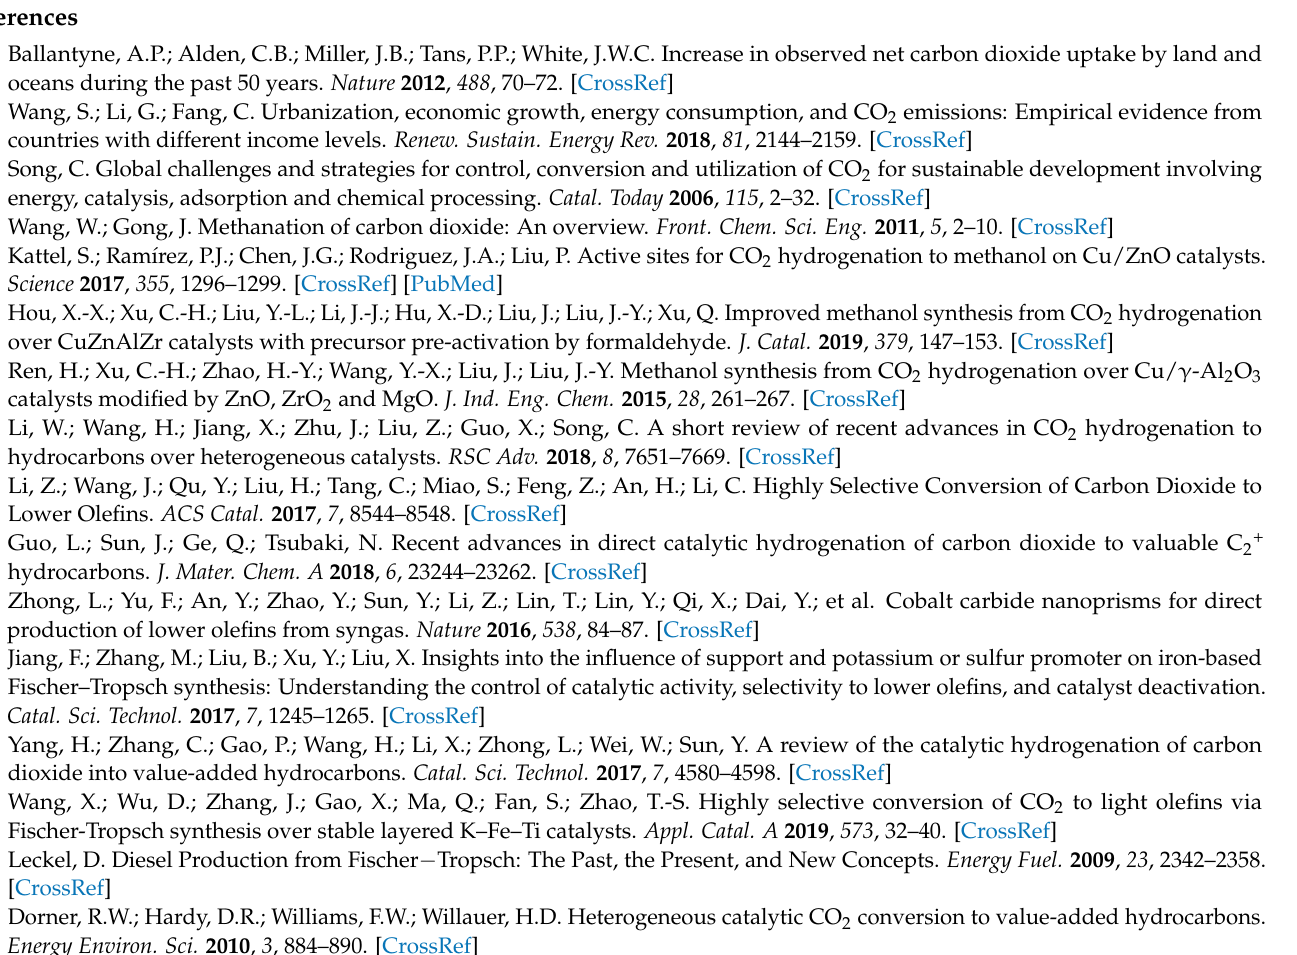
CO 2 hydrogenation, Table S2: Textural and catalytic properties of Na-promoted FCCA-K in CO 2 hydrogenation, Table S3: Textural property and catalytic performance of Na-promoted K-FCCA-N catalysts (K/Fe 9.3mol%) in CO 2